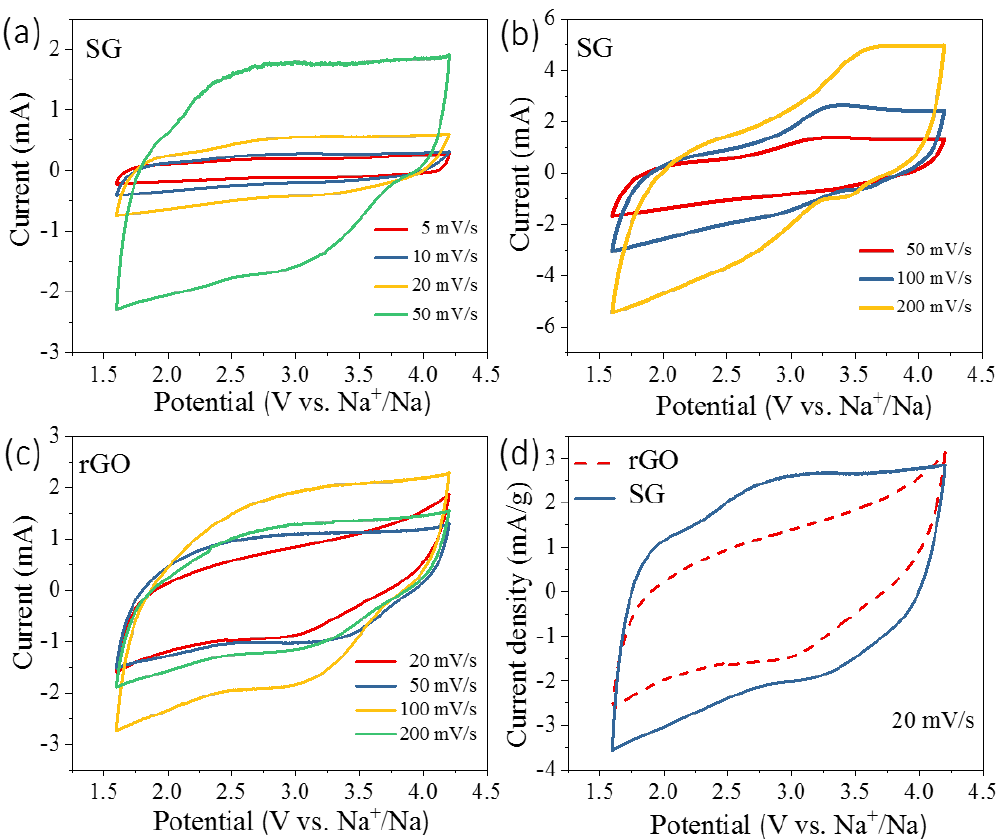
Figure 3. ( a,b ) Cyclic voltammetry (CV) curves of SG at different scan rates; ( c ) CV curves of rGO at different scan rates; and ( d ) comparison of CV curves of SG and rGO samples.